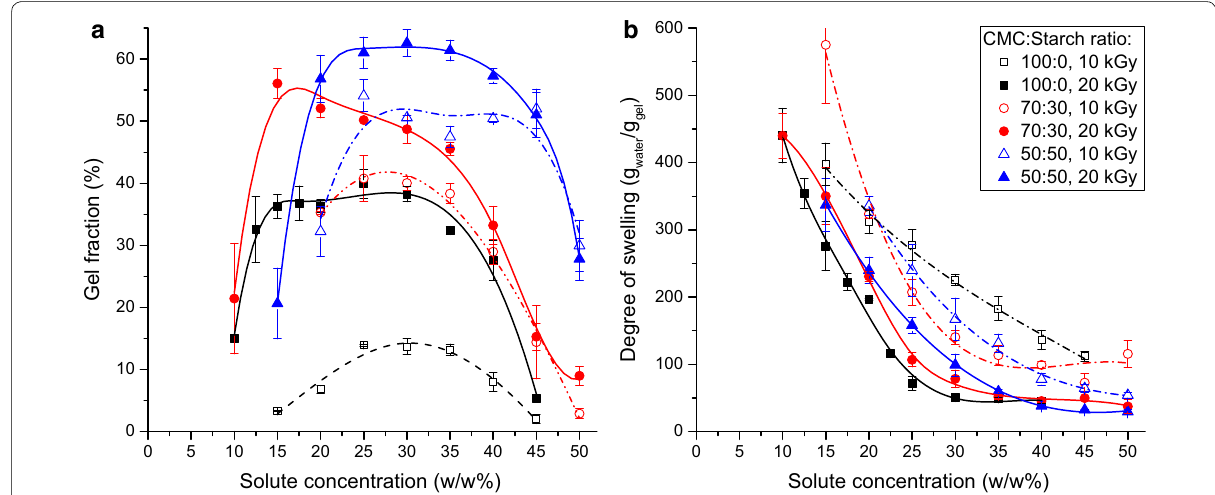
Fig. 5 The effect of the solute concentration on the gel fraction ( a ) and on the degree of swelling ( b ) of various CMC/starch gels (absorbed dose: 10 or 20